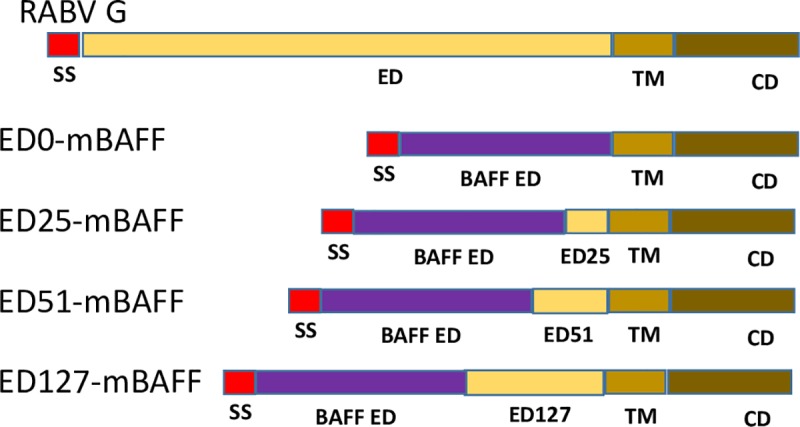
Construction of virus membrane-anchored murine BAFF.To construct a chimeric RABV G/BAFF fusion protein, the RABV G signal sequence and ED was replaced with an IL-2 signal sequence and the BAFF ED (ED0-mBAFF). Membrane-proximal 25, 51, or 127 amino acids of the RABV G ED were reintroduced into ED0-mBAFF, resulting in ED25-mBAFF, ED51-mBAFF and ED127-mBAFF, respectively.